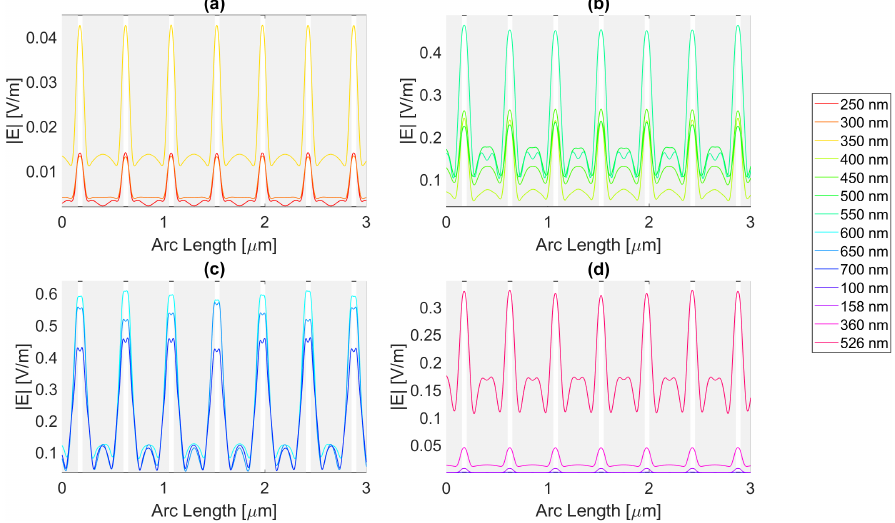
Figure 11. Electric field for copper 50-nm-thick rectangular nanostructure—Probe